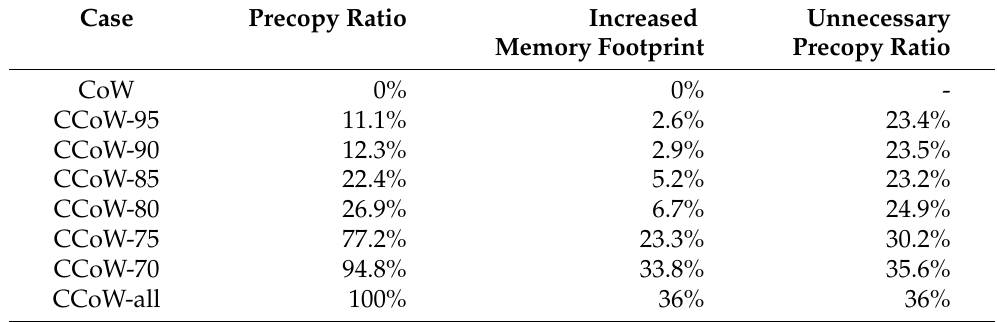
Table 1. CCoW rates in the